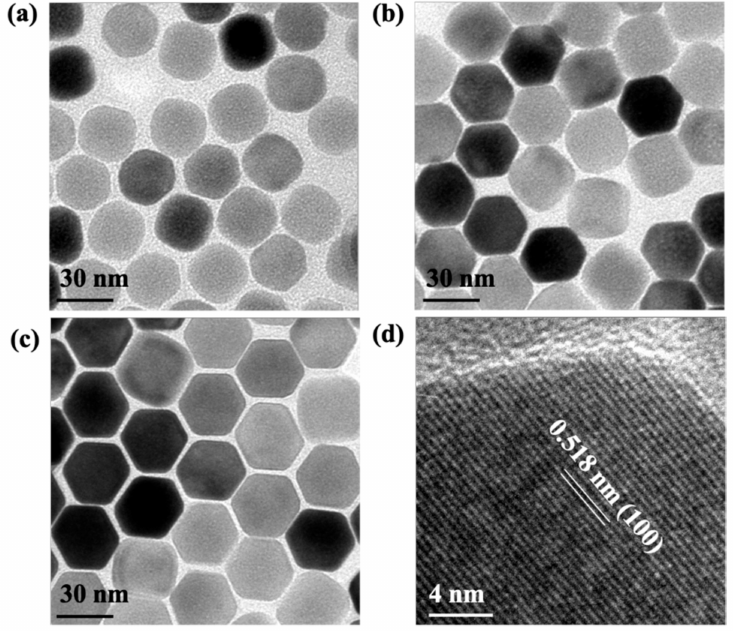
Figure 2. TEM images of: ( a ) C ( b ) CS, ( c ) CSS UCNPs. ( d ) HRTEM image of a single CSS UCNP. The high-purity β − phase of the C, CS, and CSS UCNPs were examined using XRD measurement (see Figure S1, in supplementary materials). The XRD analysis clearly indicates that all three types of the UCNPs had identical diffraction peaks to those of